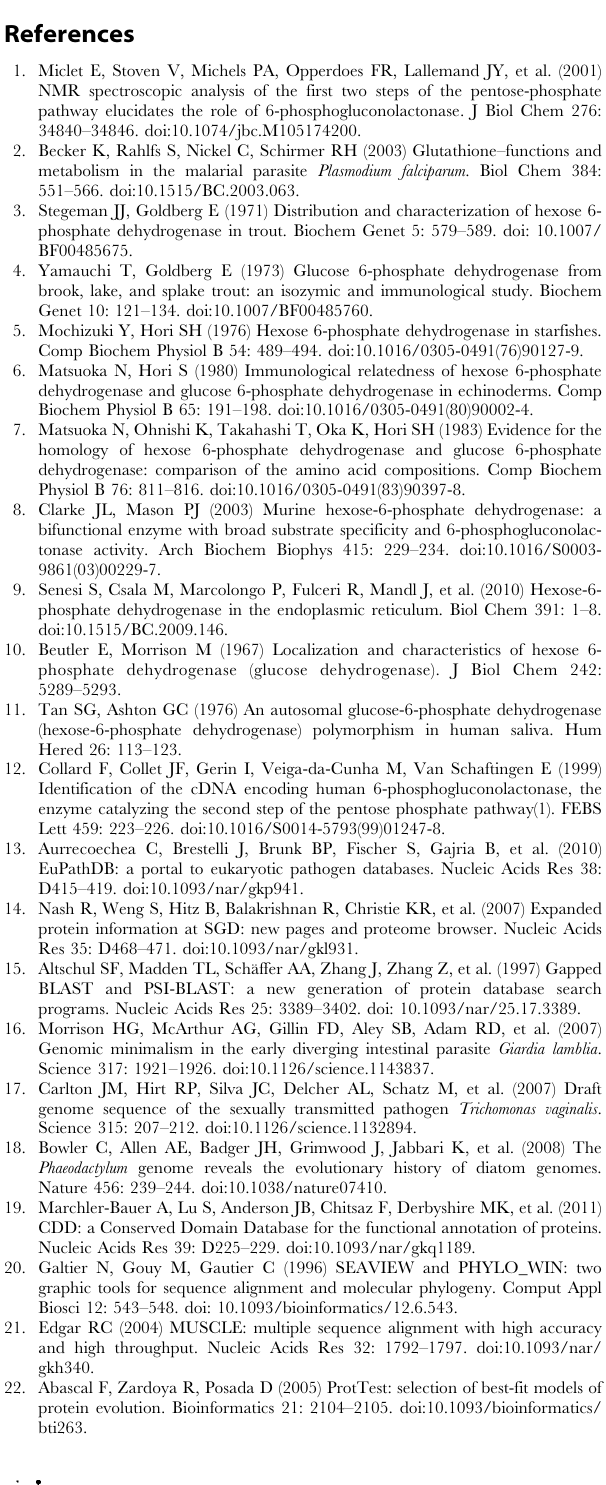
Figure S1 Complete version of the maximum likelihood tree of G6PD protein sequences shown in Figure 5. Bootstrap values are given in the tree nodes. Red indicates fused genes. A key for the abbreviations used to represent the sequences in the tree is given in Table S1.